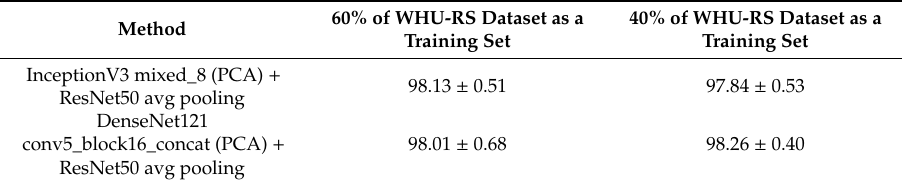
Table 8. The classification accuracy (OA (%) and SD) of the examined method, with 60% and 40% of the WHU-RS dataset as a training set.